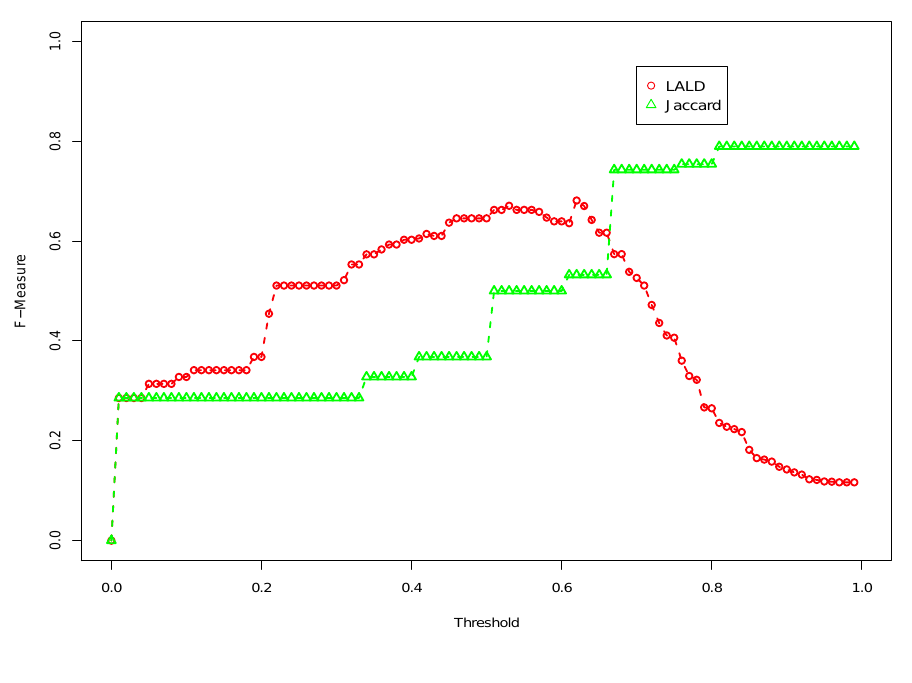
Figure 3. Comparison of dissimilarity